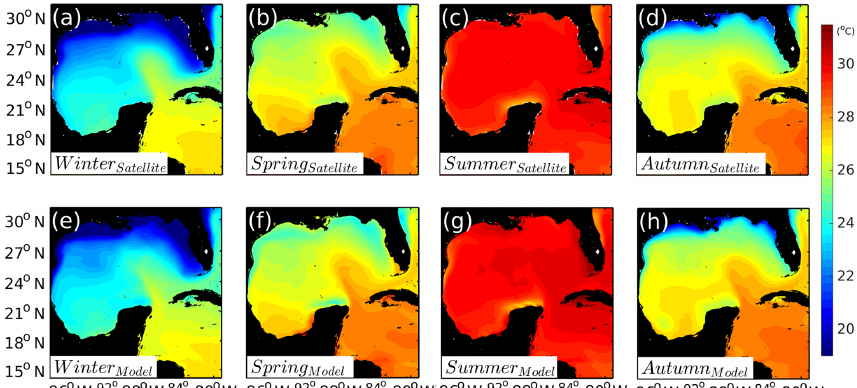
Figure A2. Seasonal climatologies of SST ( ◦ C) for the GoM (2005 to 2012). Comparison between (a–d) satellite SST product and (e– h) model SST.